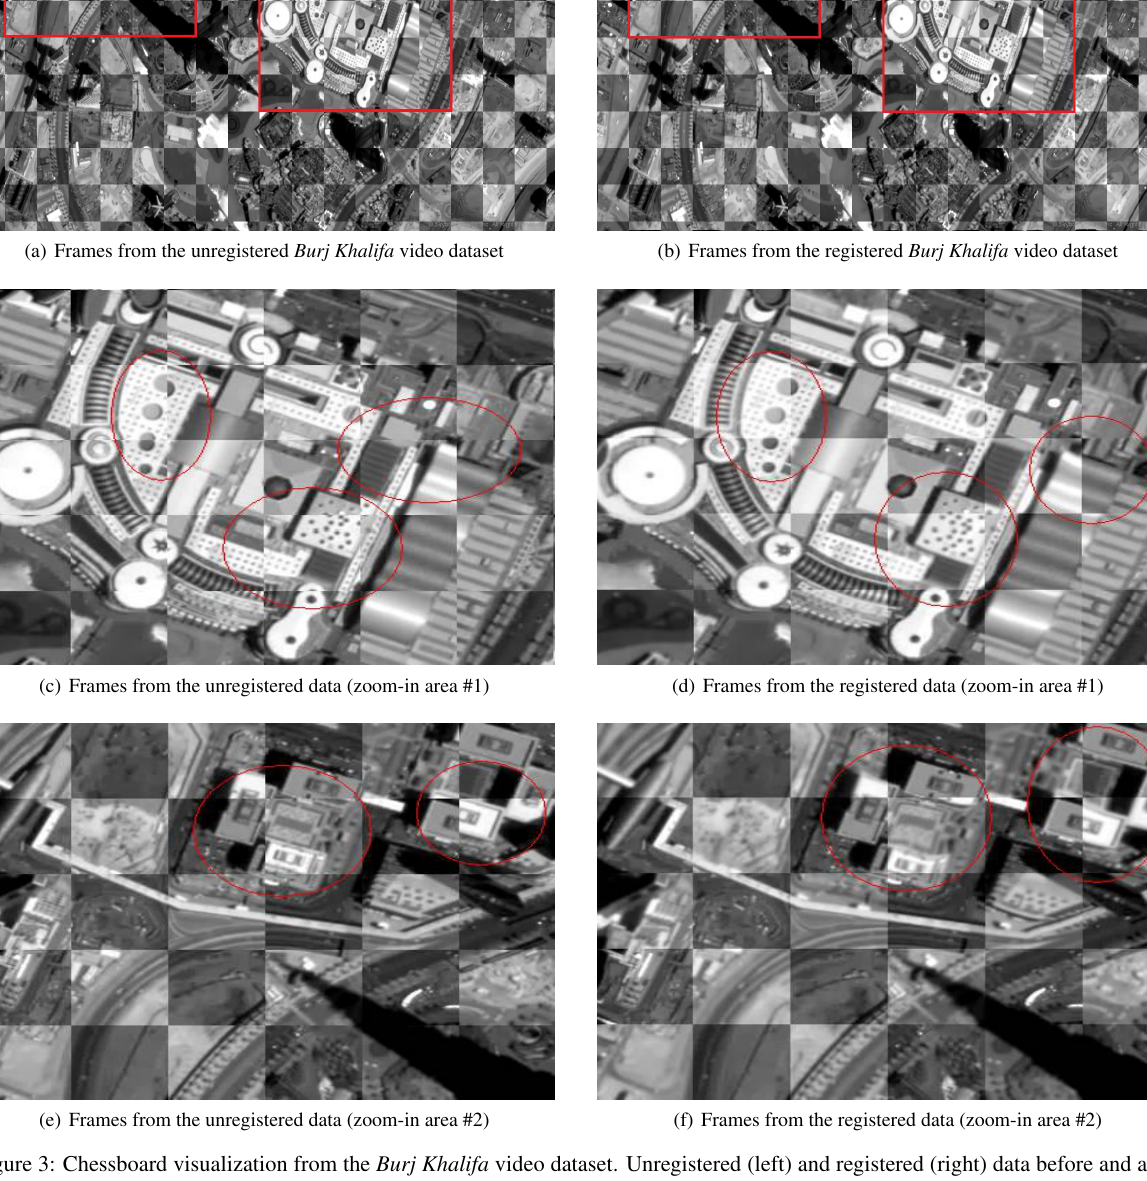
Figure 3: Chessboard visualization from the Burj Khalifa video dataset. Unregistered (left) and registered (right) data before and after the application of the proposed methodology.